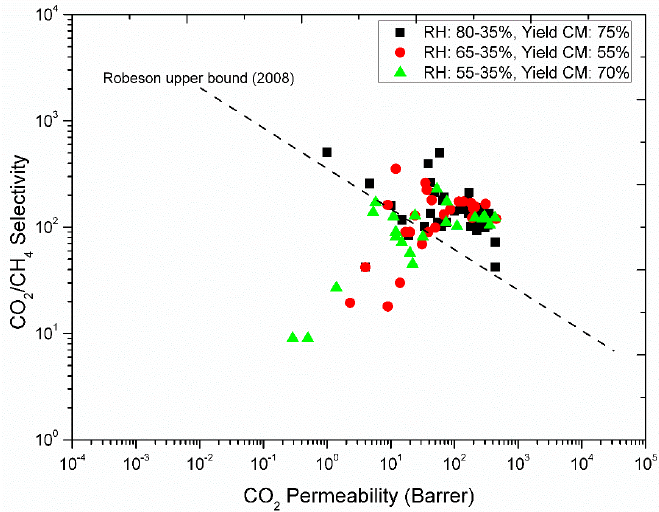
Figure 15. Gas permeation properties of carbon hollow fibers from regenerated cellulose precursor (RH: 80–35%; Black squares, RH: 65–35%; Red circles, RH: 55–35%; green triangles).